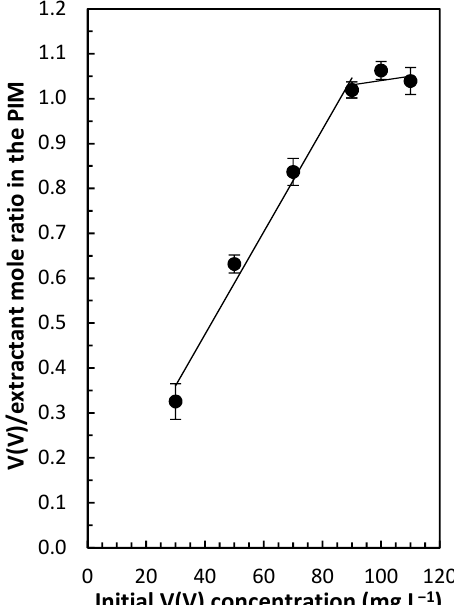
Figure 5. The variation of V(V)/Aliquat ® 336 mole ratio in the PIM studied (50 wt% PVDF-HFP, 40 wt% Aliquat ® 336 and 10 wt% DBP) as a function of the initial V(V) concentration in the aqueous source solution, containing 0.2 mol L −1 sodium sulfate and adjusted to pH 2.5. PIMs/aqueous source solution contact time and temperature were 24 h and 22 ± 1 °C, respectively. Error bars = ± SD.